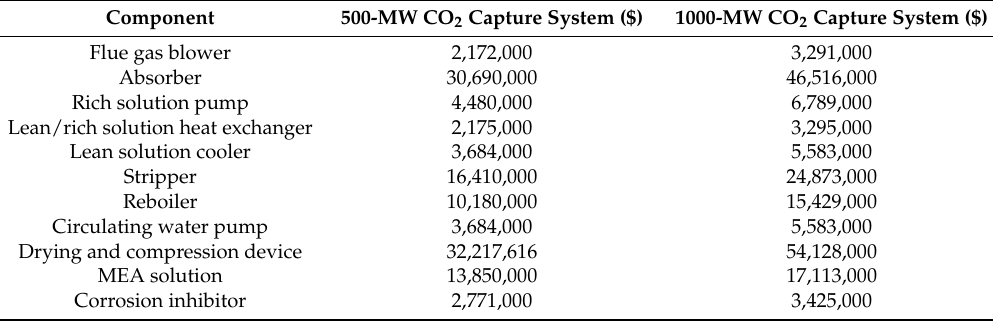
Table A3. Investment of Each Component in the MEA-Based CO 2 Capture Subsystem